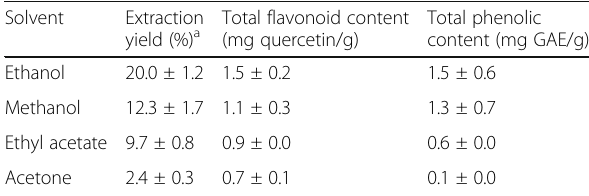
Table 1 Flavonoid and phenolic acids contents of C.azarolus var. eu- azarolus leaves extracts